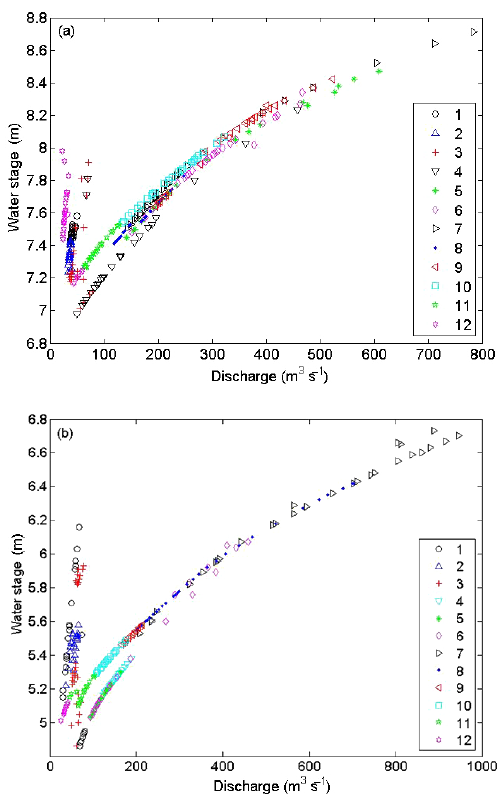
Figure 4. Monthly stage–discharge relationships for Jimai hydro- logical station in the Dari reach (a) 1968 (b) 1984 (note: number refers to month, e.g., 1 for January and 12 for